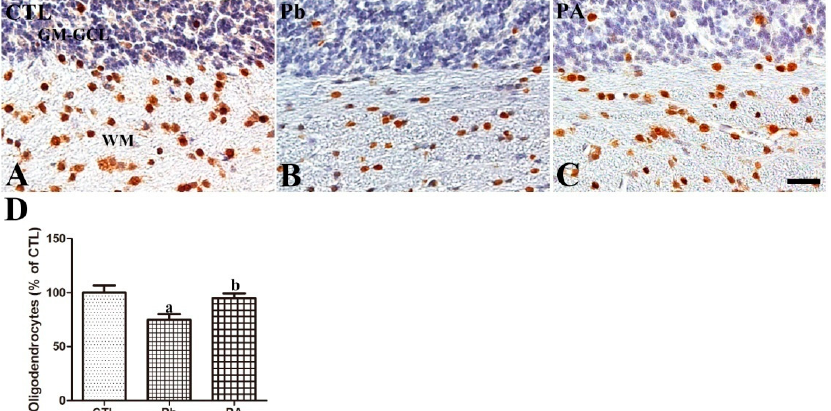
Figure 4. Immunohistochemistry for oligodendrocytes (brown) in the cerebellum ( A , B , and C ) of offspring from CTL, Pb, and PA groups. Note that the numbers of Olig2-positive oligodendrocytes in the cerebellum are reduced in the Pb group, and ascorbic acid treatment ameliorated these reductions in the PA group. GM-GCL (blue), granule cell layer in gray matter; WM, white matter. Bar = 25 μ m. ( D ) The numbers of OPN-positive Purkinje cells in the cerebellar cortex are expressed as percentages of the value in the CTL group ( n = 12 offspring per group; a p < 0.05, indicating asignificant difference compared with the control group, b p < 0.05, indicating a significant difference compared with the Pb group). The bars indicate the means ± standard errors of the mean. 3.5. Effect of Pb Exposure and Ascorbic Acid Treatment on MAG Expression in the Developing Cerebellum MAG is transmembrane protein and is functionally classified as the protein component in the myelin sheath of nerve fibers [26]. In the cerebellum, MAG was commonly observed in the myelinated fibers of white matter tracts in all groups. The MAG immunoreactivity was reduced in the cerebellum of pups by prenatal and postnatal Pb exposure (57.66% of that in the control group, p < 0.01). However, ascorbic acid co-treatment with Pb ameliorated the Pb-induced reduction in the MAG immunoreactivity (88.35% of that in the control group, p < 0.05) to near the control level ( p > 0.05) (Figure 5). Figure 5. Immunohistochemistry for myelin-associated glycoprotein (MAG, brown) in the cerebellum ( A , B , and C ) of offspring from CTL, Pb, and PA groups. Note that the MAG-immunoreactivity in the WM in the cerebellum are reduced in the Pb group, and ascorbic acid treatment ameliorated this reduction in the PA group. GM-GCL (blue), granule cell layer in gray